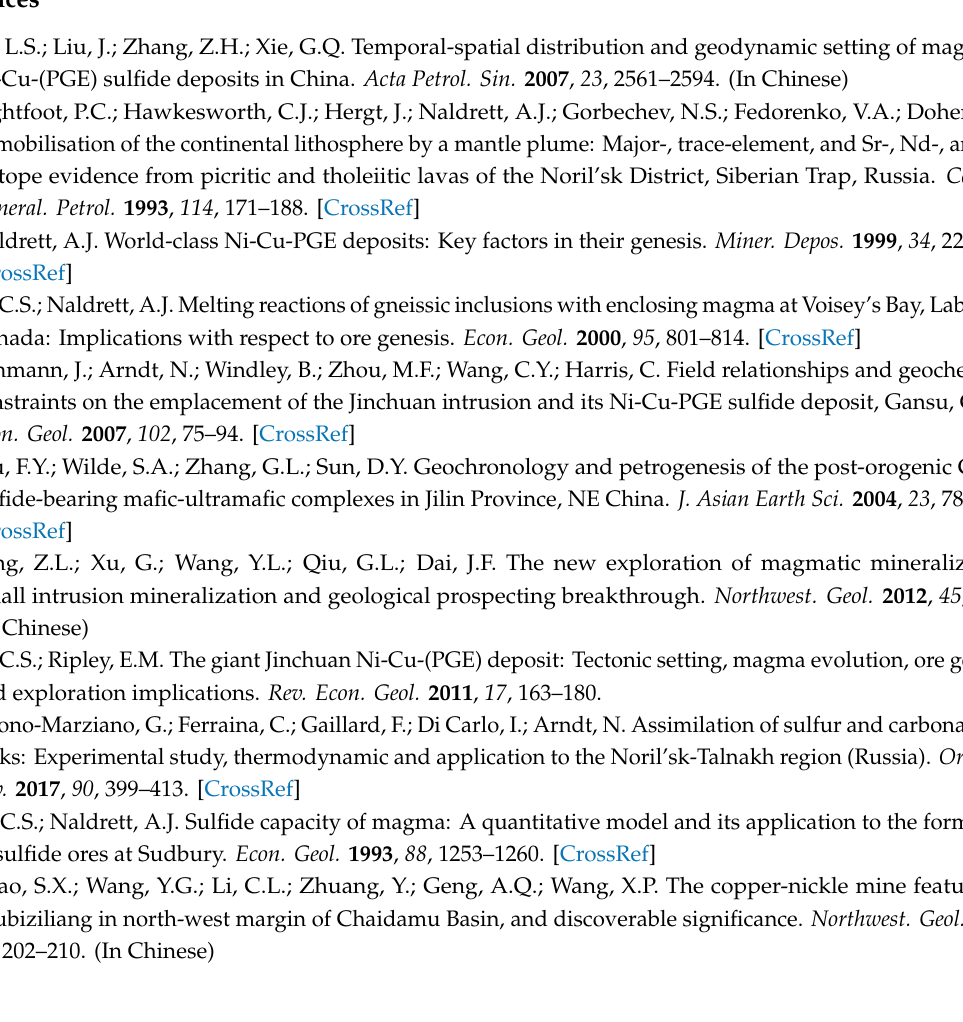
Table S1: The spectral lines, standards and count times that were used and average of detection limits of electron microprobe analysis, Table S2: Electron microprobe analyses (wt%) of olivine from the Niubiziliang mafic-ultramafic complex, Table S3: Electron microprobe analyses (wt%) of pyroxene from the Niubiziliang mafic-ultramafic complex, Table S4: Electron microprobe analyses (wt%) of plagioclase from the Niubiziliang mafic-ultramafic complex, Table S5: Electron microprobe analyses (wt%) of hornblende from the Niubiziliang mafic-ultramafic